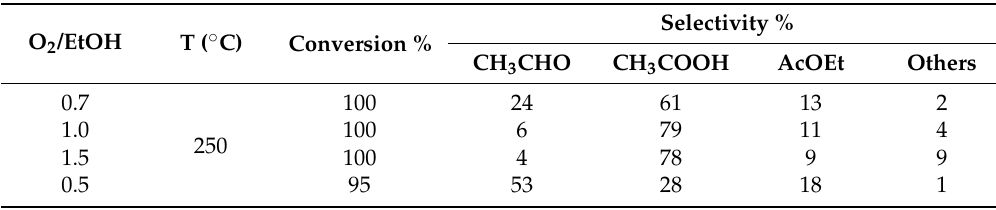
Table 4. Performance of cat M (16.3% Au/silicalite-1 doped with alkali, CH 3 COOK/Au = 20) in ethanol conversion.